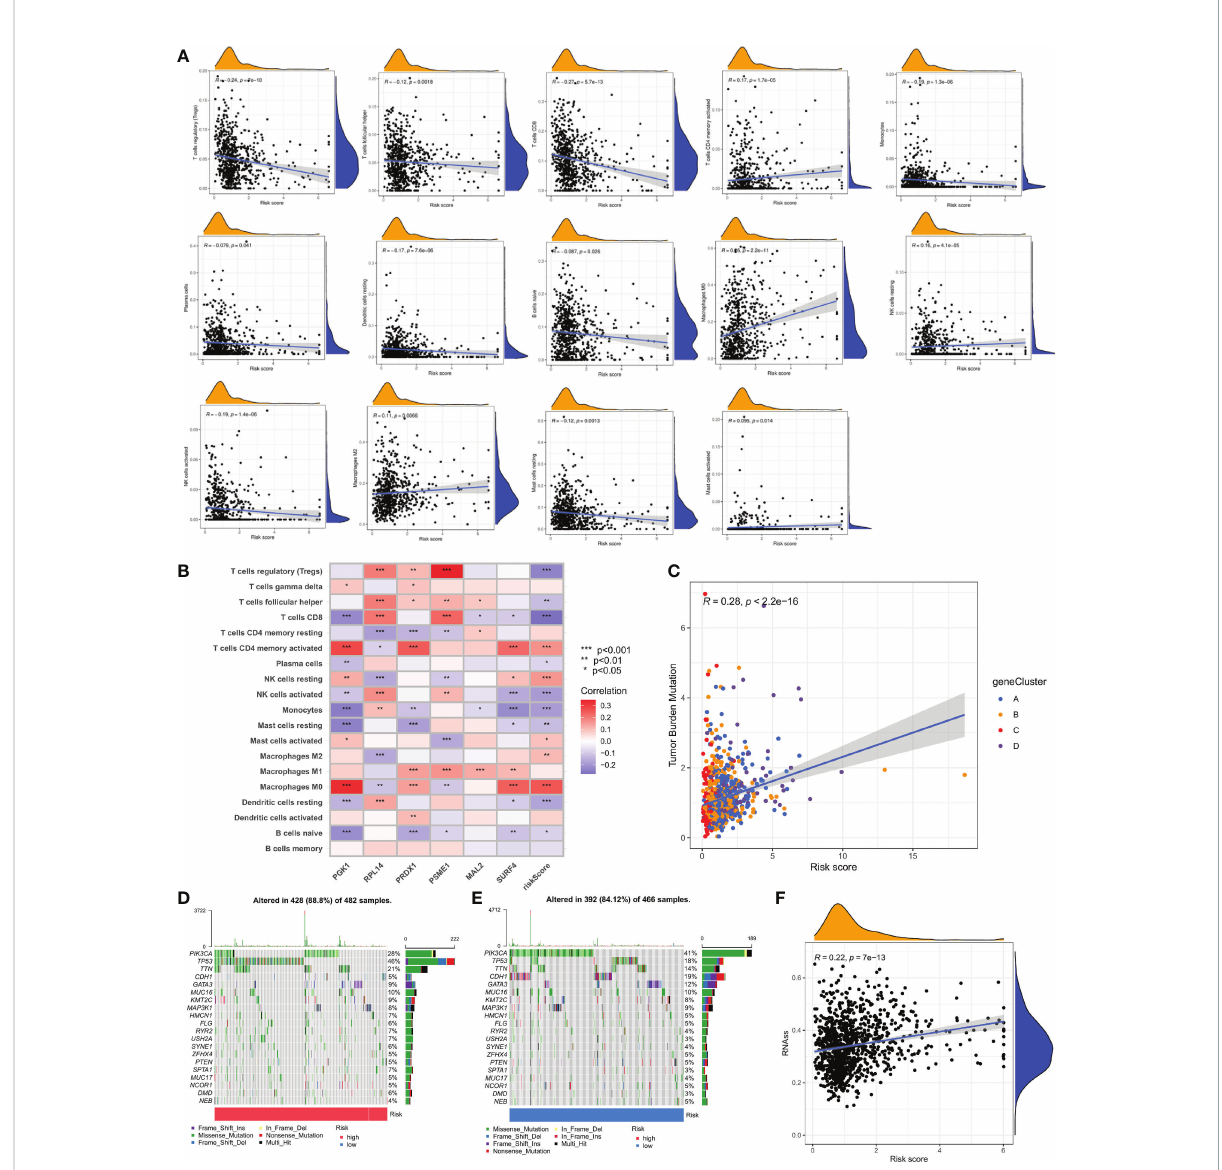
FIGURE 8 Comprehensive analysis of the CRG scores in BC. (A) Correlations between immune cell types and CRG score. (B) The six genes from the proposed model are correlated with the number of immune cells. (C) CRG score and TMB spearman correlation analysis. (D, E) The somatic mutation features waterfall plot determined by high and low CRG scores. One patient was represented by each column. The correct number represented each gene's frequency of mutation, and the upper barplot displayed TMB. The proportion of each variant type was displayed in the right barplot. (F) Associates between the CSC index and the CRG